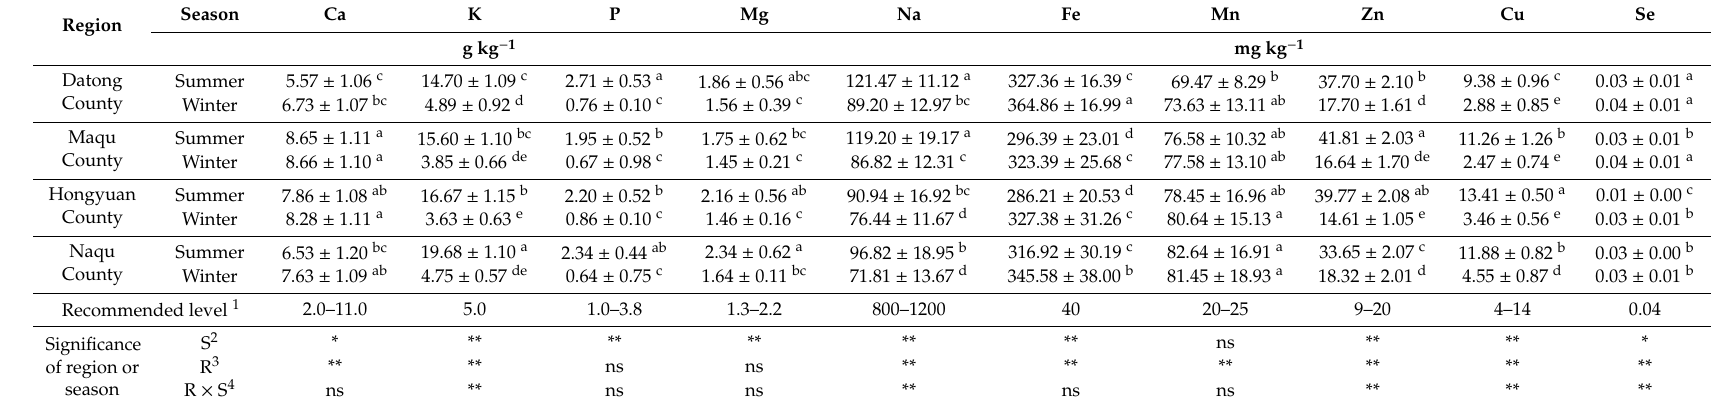
Table 3. Macro and micro mineral concentrations (DM) in forage samples (mean ±